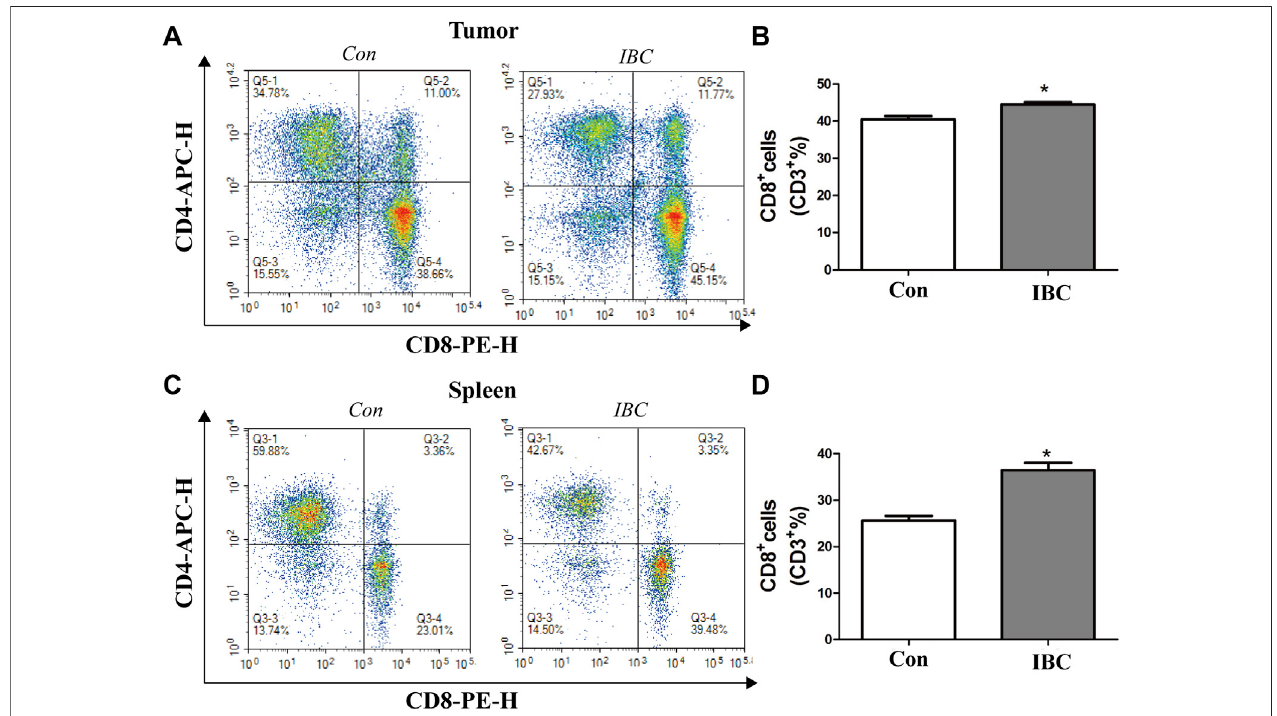
FIGURE11|(A,B) Intumor tissues,therepresentative image oftheCD8 + proportion wasreported. Thecolumns representthemean ±SEM. Student ’ s t -test was applied to analyze the data, * p < 0.05 versus the control. (C,D) Proportion of CD8 + in the spleen was reported, * p < 0.05 versus the control.